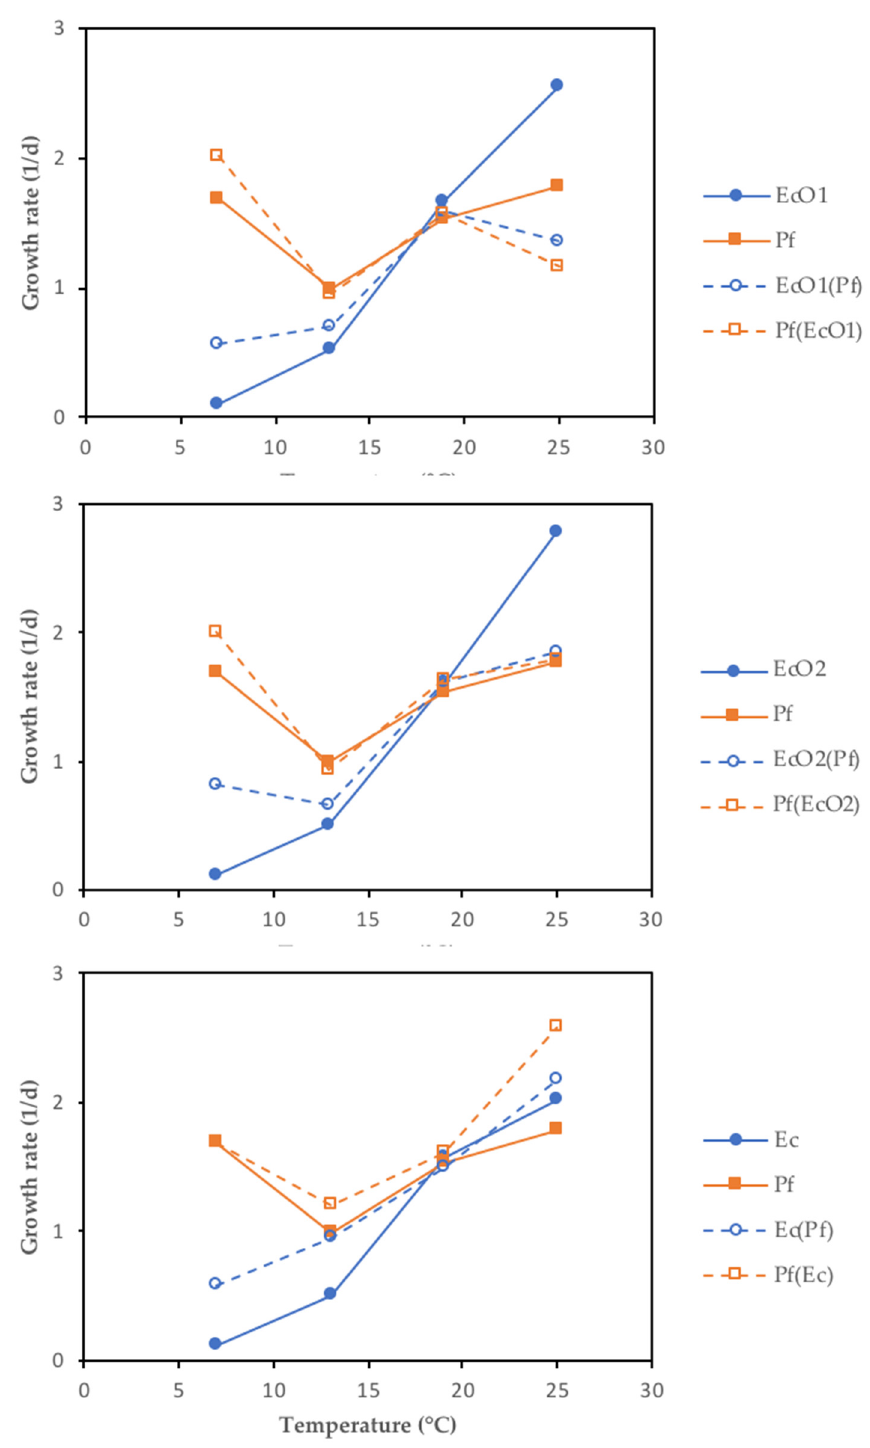
Figure 4. Scatter plots of the growth rates ( µ mean) from E. coli spp. co-cultured with P. fluorescens (EcO1(Pf), EcO2(Pf), andEc(Pf))orsingle-cultured(EcO1, EcO2, andEc)at7, 13, 19or25 ◦ C.Growthrates from P. fluorescens co-cultured (Pf(EcO1), Pf(EcO2), and Pf(Ec)) or single-cultured (Pf) are also shown. ◦ At 7 C, decreasing populations of the three E. coli strains cultured alone were not shown.